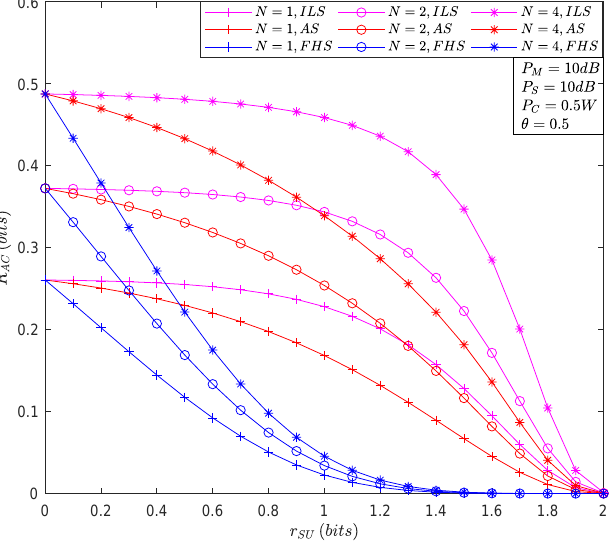
Figure 5. The ACR versus r SU for the different number of